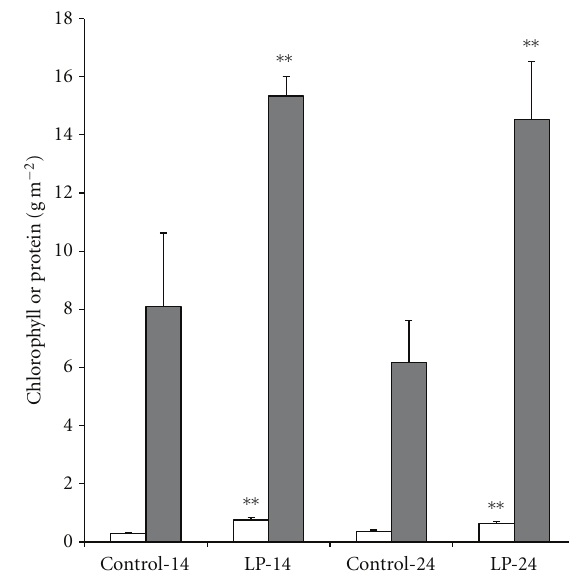
Figure 4: Leaf chlorophyll and total protein contents in soybean plants grown with original pots (Control) and with larger pots (LP). Summary of growth conditions is described in Figure 1. Open bar,